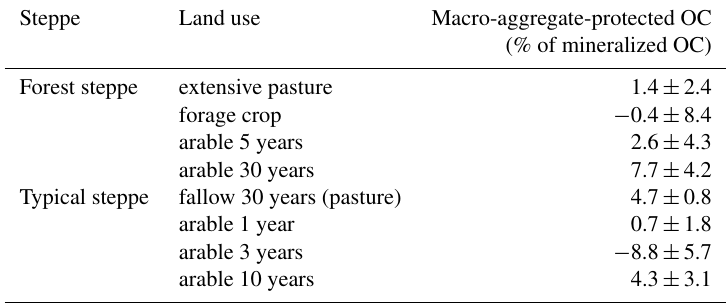
Table 3. Proportion of macro-aggregate-protected OC (% of mineralized OC) as arithmetic mean ± SE for two steppe types and the respective land use. Since the proportion of macro-aggregate-protected OC has been calculated by subtracting the amount of OC mineralized in intact macro-aggregates from that in crushed macro-aggregates, negative values occur when the OC mineralization was smaller in crushed than in intact macro-aggregates.